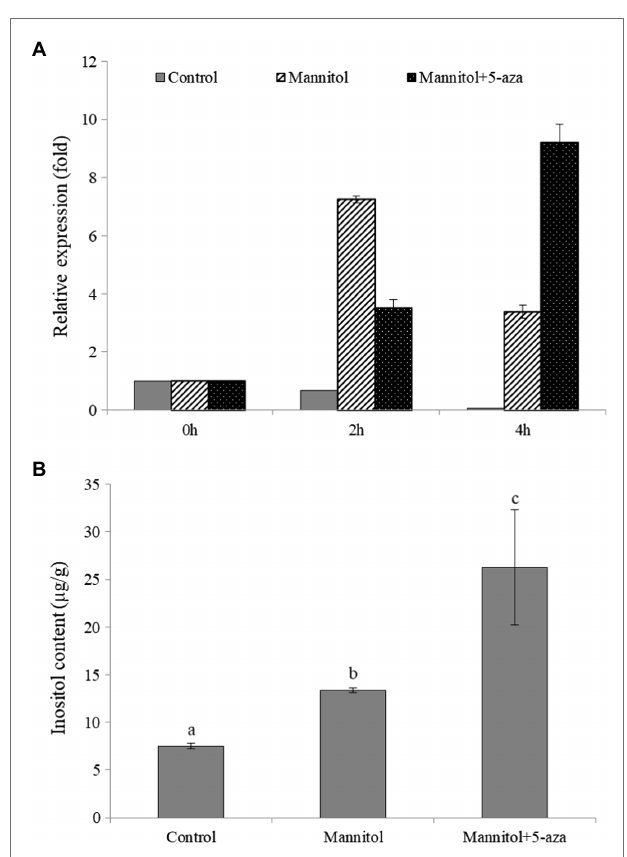
FIGURE 7 | The osmotic regulation of inositol on watermelon cells may be associated with DNA methylation. (A) The effect of different treatments on the expression of ClMIPS1 . (B) The effect of different treatments on the accumulation of inositol. Different lowercase letters mean significant differences ( p < 0.05). Values are means ± SD of three biological